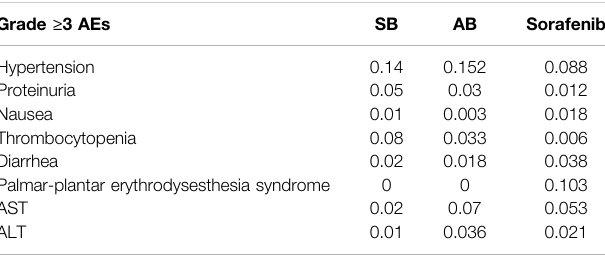
TABLE 2 | Incidence of adverse